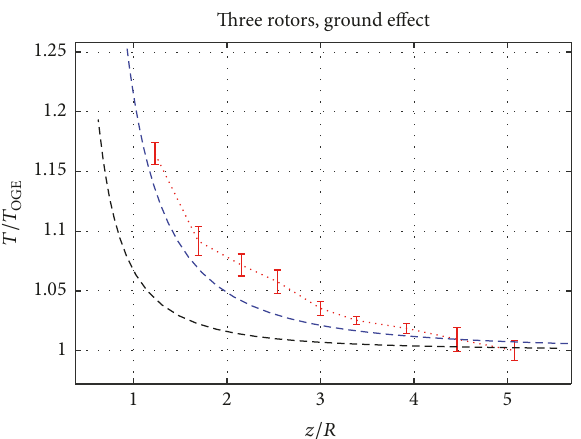
Figure 8: Red error bar: experimental and theoretical results of the increment in the thrust generated by three rotors as a function of the distance to the ground plane. Black dashed line: theoretical results of the PFI method for a single rotor. Blue dashed line: theoretical results of the PFI method for three rotors.